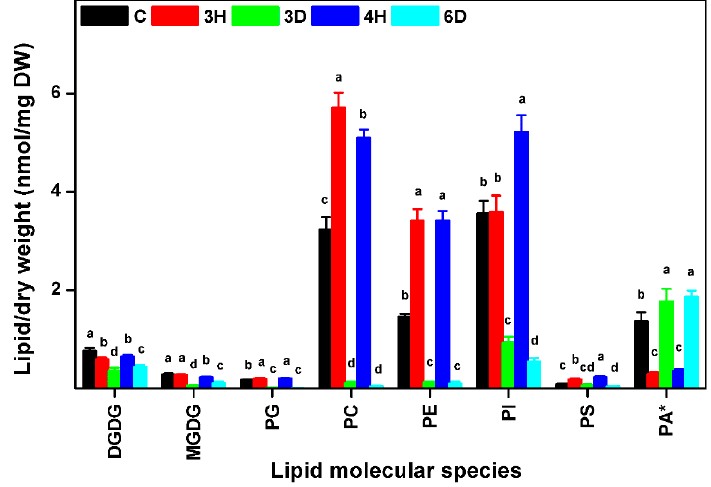
Figure 4. Amounts of membrane lipids in each head-group class in A. thaliana seeds during hydration–dehydration cycles. The treatment was the same as that described in Figure 3. DGDG, digalactosyldiacylglycerol. MGDG, monogalactosyldiacylglycerol. PG, phosphatidylglycerol. PC, phosphatidylcholine. PE, phosphatidylethanolamine. PI, phosphatidylinositol. PS, phosphatidylserine. PA, phosphatidic acid. DW, dry weight. Each value is mean ± SD ( n = 4 or 5). Bars for the same lipid class with different letters indicate that the values were significantly different ( p < 0.05). * The PA content was published previously [34].